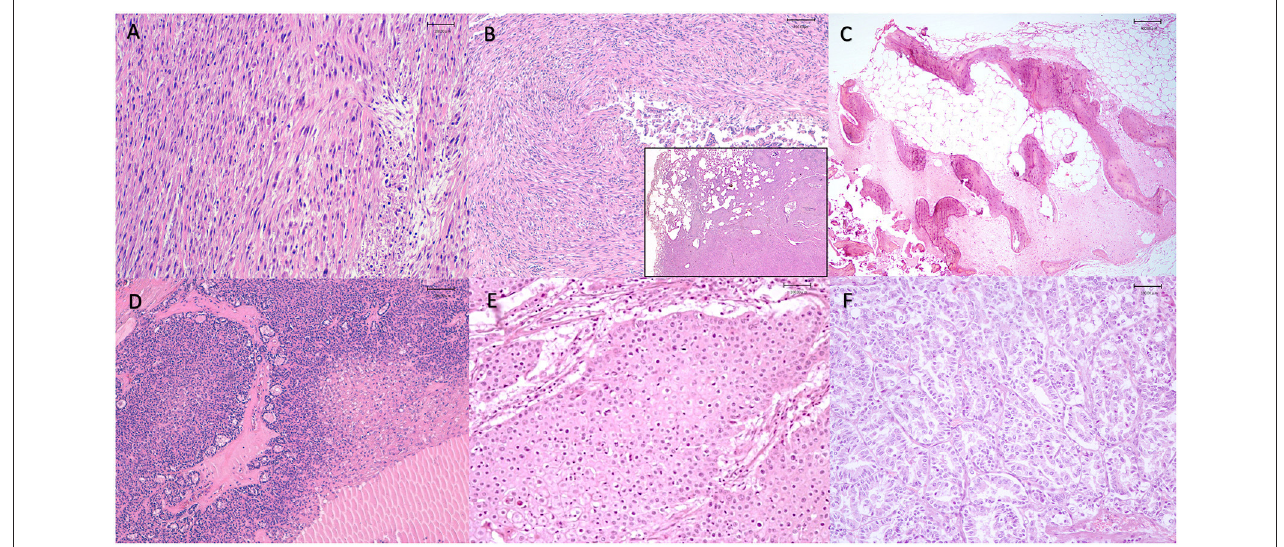
FIGURE 2 | Representative neoplasms observed in captive wild felids in our study. (A) Spleen, metastatic squamous cell carcinoma, presence of numerous multiple round, white and firm nodules, Tiger ( Panthera tigris ), (B) Lungs, metastatic squamous cell carcinoma, presence of round, white and firm nodules, Tiger ( Panthera tigris ), (C) Uterus, leiomyoma, presence of multiple, white to yellow, firm masses, Lion ( Panthera leo ), (D) Liver, hemangiosarcoma, presence of multiple, red and white, soft masses that on cut surface appear mottled dark red and show an honeycomb appearance from tumor vascular spaces and abundant hemorrhage, Lion ( Panthera leo ), (E) Ribs, osteoma, presence of a solid, whitish mass extended from the 5th to the 7th rib, Tiger ( Panthera tigris ), (F) Liver, cholangiocarcinoma, presence of numerous red to white, coalescing cystic lesions, Leopard ( Panthera pardus